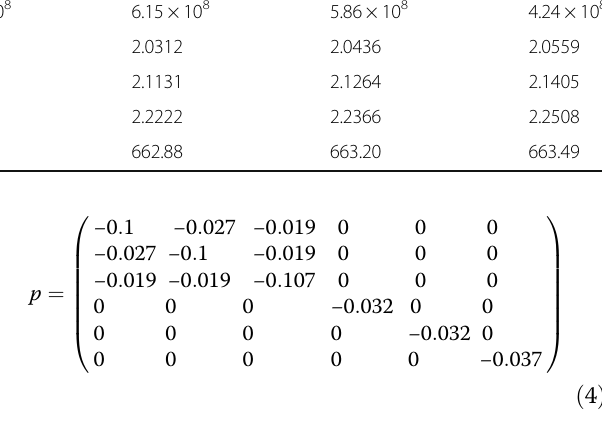
Table 1 The TDDs, refractive index, and Raman E 2 ( h ) peak positions of AlN samples Samples